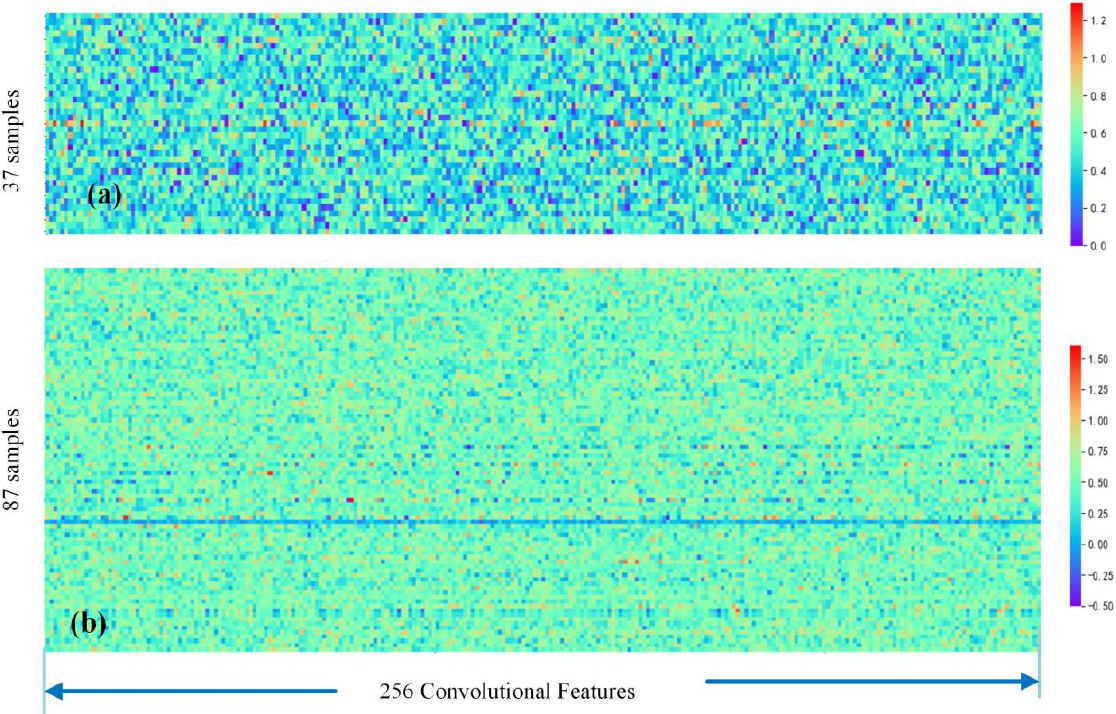
Figure 3. 256-dimensional convolutional features extracted from fully connected layers of dataset, including (a) validation set, and (b) calibration set.